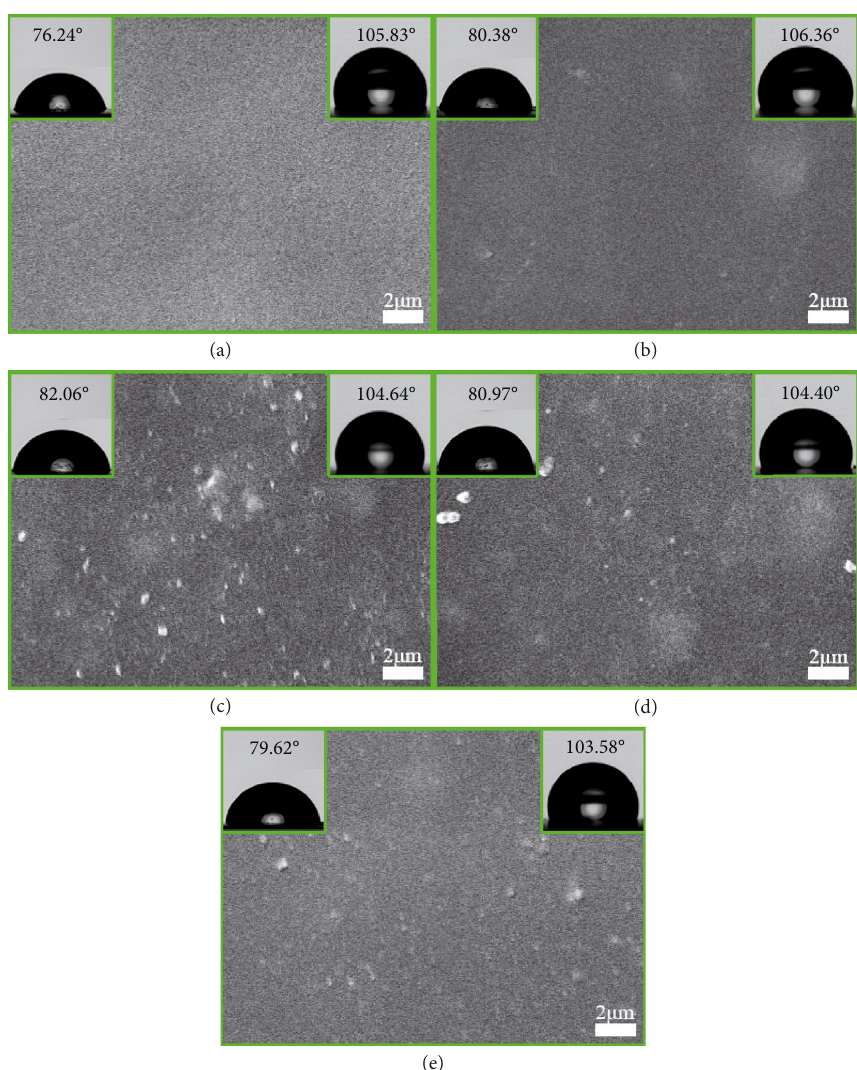
Figure 7: SEM images of organosilicon antisticking coatings. (a) 30wt.% methyl vinyl MQ silicone resin. (b–e) Coating with 1wt.%, 2wt.%, 3wt.%, and 4 wt.% nano-SiO 2 powder on the basis of (a), respectively. The contact angles of the left and right labels in each image were separately those of ethylene glycol and deionized